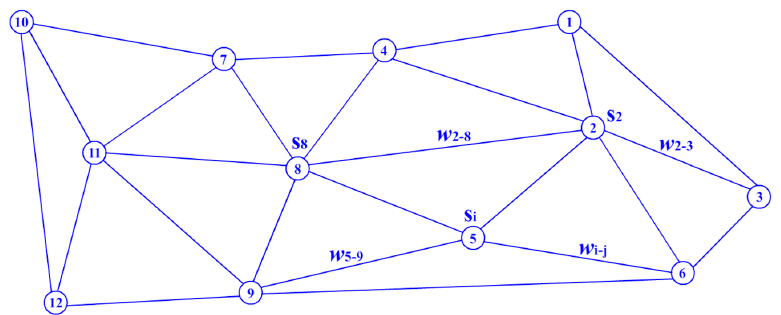
Figure 2. Illustration of an adjacent graph for a sensor network.